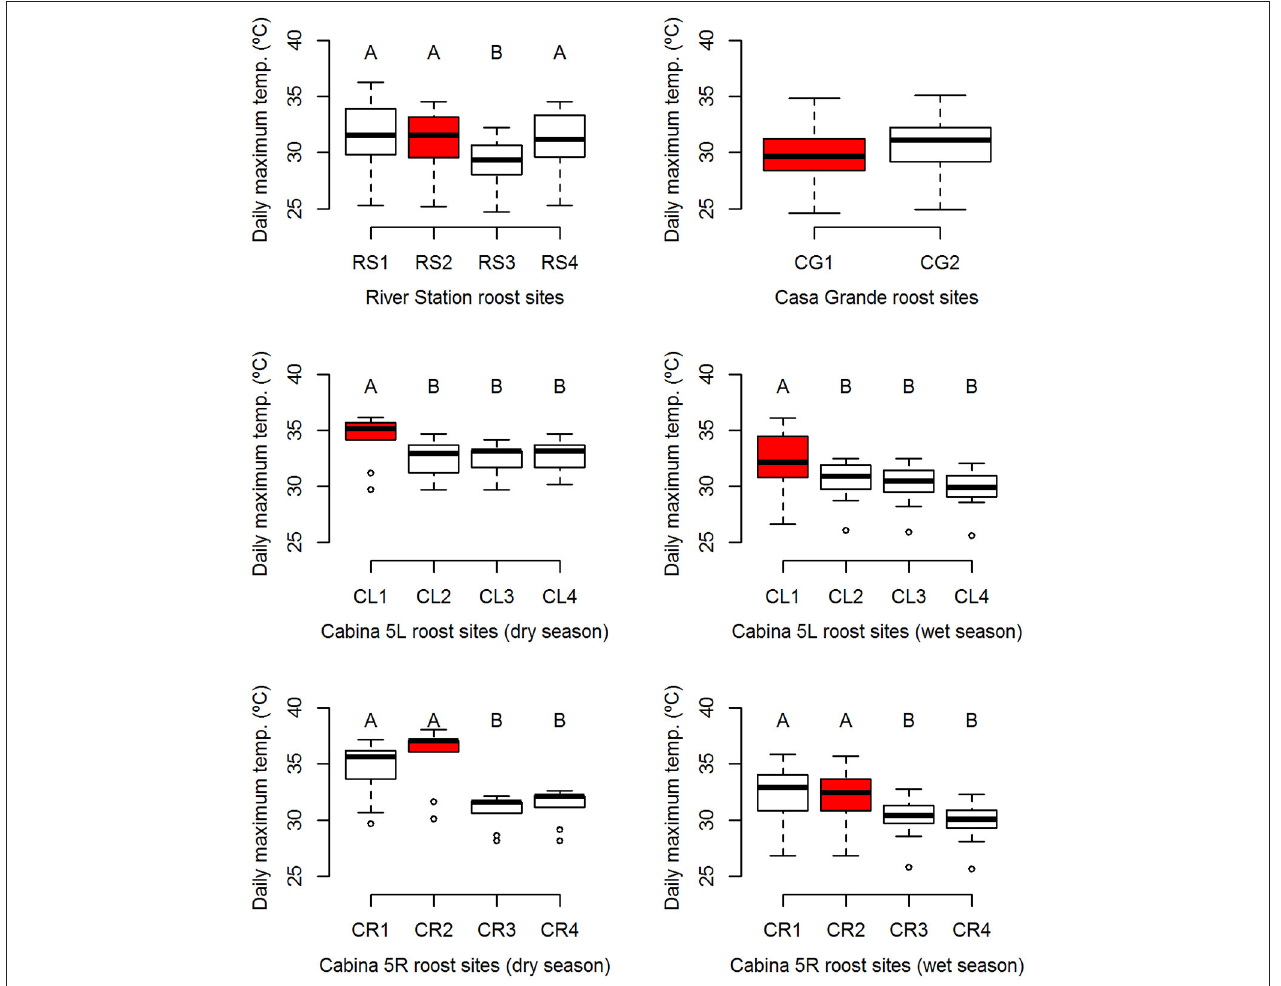
FIGURE 1 | Boxplots of daily maximum temperatures at the studied roost sites per social group. Boxes show median and interquartile range (IQR) and whiskers represent 1.5 * IQR. Significant differences among roost sites in Tukey post-hoc tests are represented by letters above boxplots. Shared letters are statistically similar to one another while different letters represent roost sites with significantly different maximum temperatures. Primary roost sites are highlighted red.